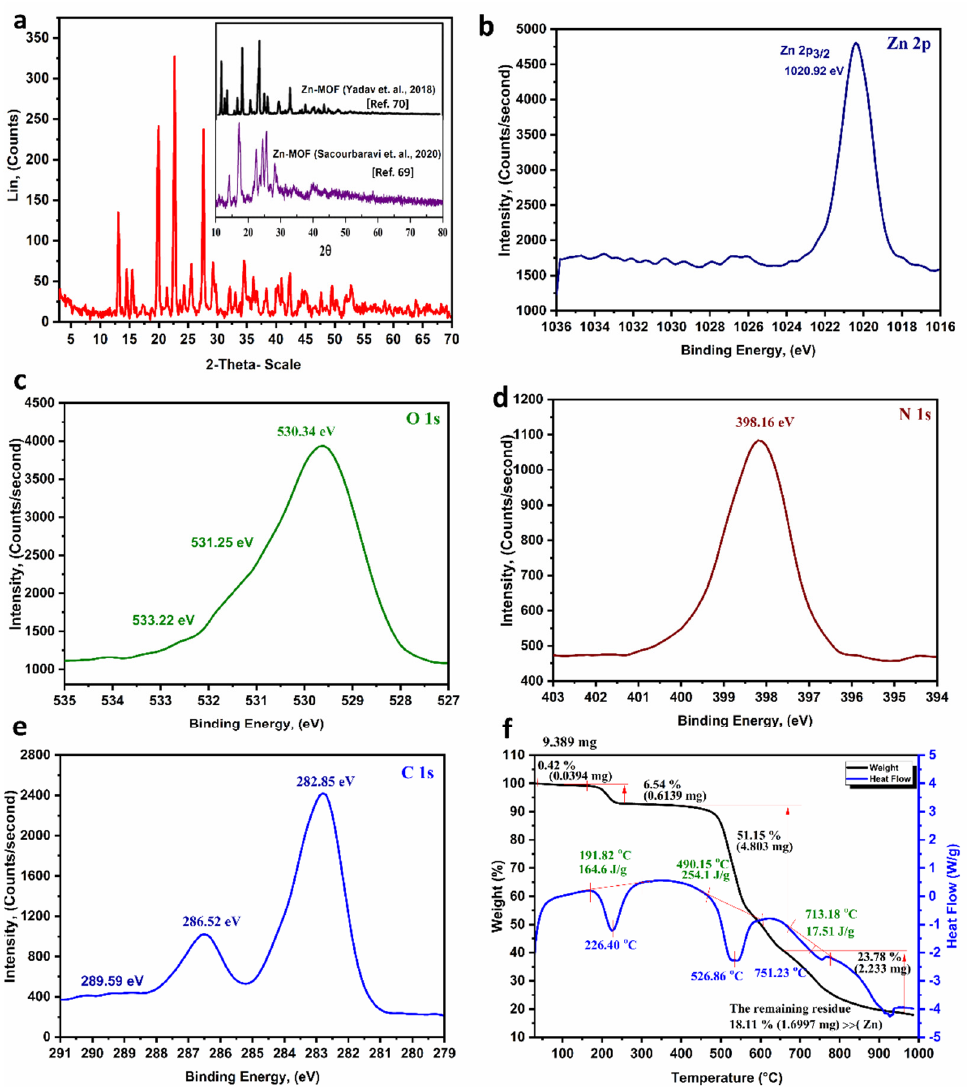
Figure 2. ( a ) The XRD patterns of the Zn-M Ο Fs-NP, ( b – e ) the XPS spectra of the Zn-M Ο Fs-NP: [Zn 2p ( b ), O 1s ( c ), N 1s ( d ), and C 1s ( e )]; and ( f ) TGA-DSC of the Zn-M Ο Fs-NP.